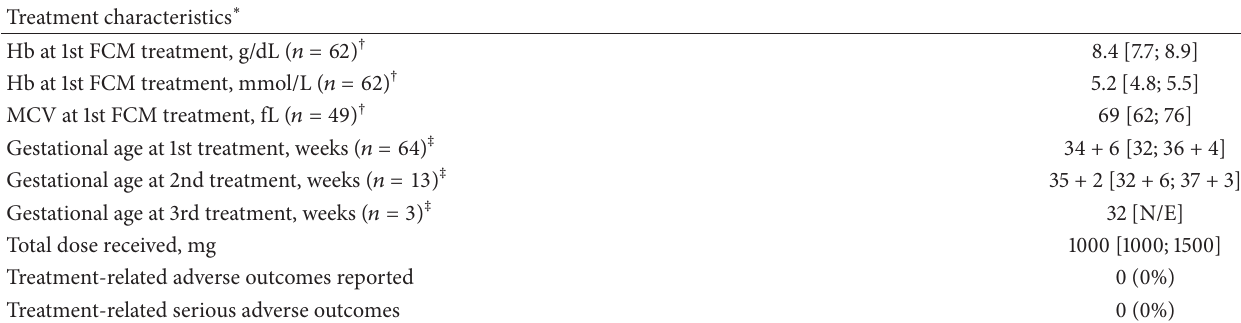
Table 2: Treatment characteristics of the case group ( 𝑛 = 64 ) treated with FCM.